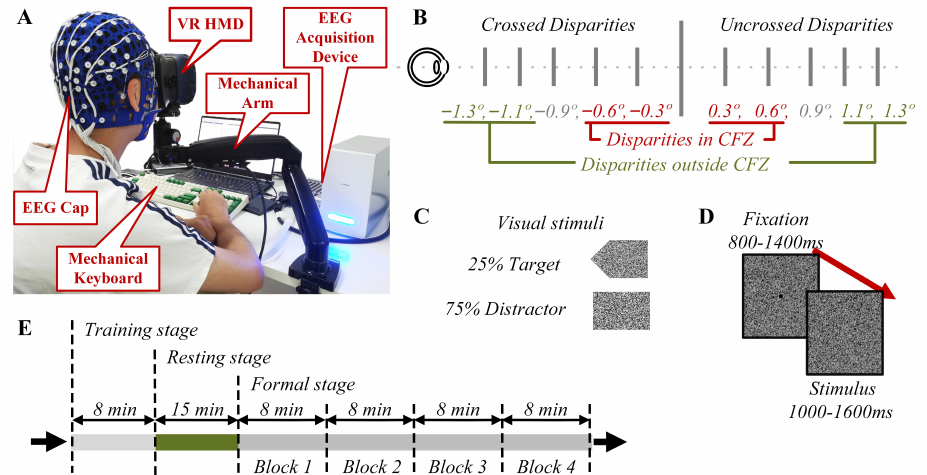
Figure 1. Schematic of the experimental environment, stimuli, trials and procedure. ( A ) Experimental environment. ( B ) Disparity design. Ten disparity settings in the experiment, with − 0.3 ◦ , − 0.6 ◦ , − 0.9 ◦ , − 1.1 ◦ , − 1.3 ◦ for the crossed disparities, 0.3 ◦ , 0.6 ◦ , 0.9 ◦ , 1.1 ◦ , 1.3 ◦ for the uncrossed disparities, − 0.6 ◦ , − 0.3 ◦ , 0.3 ◦ , 0.6 ◦ for the disparities in comfort fusion zone, − 1.3 ◦ , − 1.1 ◦ , 1.1 ◦ , 1.3 ◦ for the disparities outside comfort fusion zone. ( C ) Visual stimuli. The stimulus was divided into arrow and square shapes. The arrow stimulus was the target stimulus with a 25% occurrence probability, and the square stimulus was the interference stimulus for the Go/Nogo task with a 75% occurrence probability. ( D ) Diagram of a single trial. The duration of 0 ◦ disparity planes as fixation reference was 800–1400 ms, and the presentation duration of the subsequent stimulus was 1000–1600 ms. ( E ) Experimental procedure. Three consecutive stages were performed in this